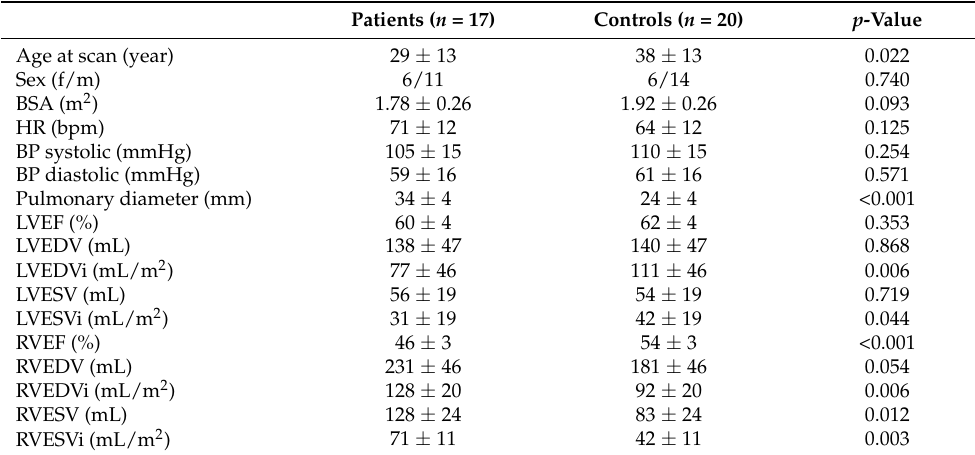
Table 3. Baseline characteristics from cardiac magnetic resonance imaging.